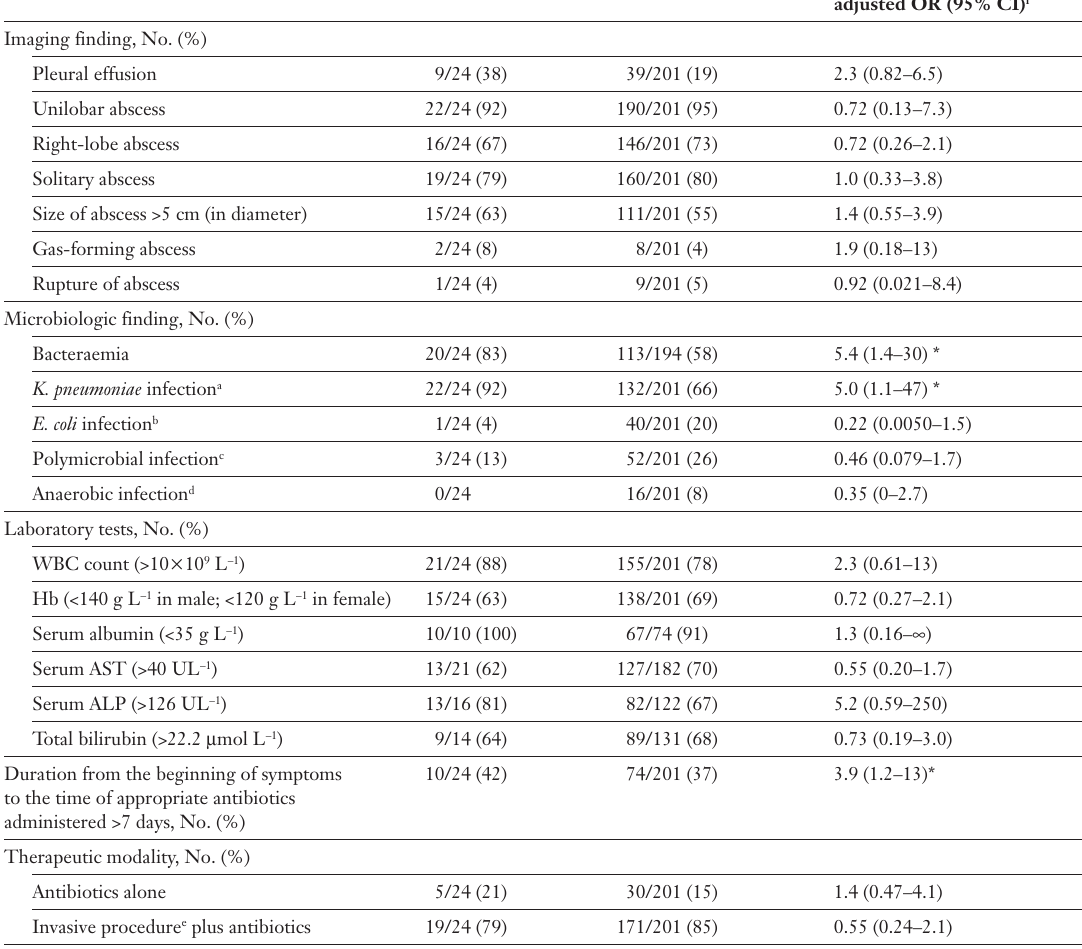
Imaging, microbio- logic, and laboratory findings at admis- sion, and initial treat- ment in the metasta- tic and non-metasta- tic infection groups.